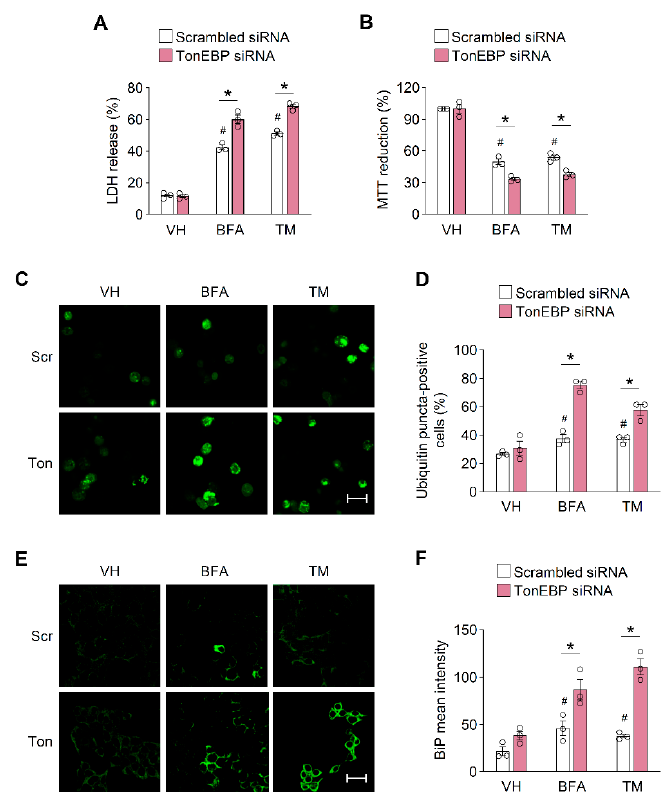
Figure 1. Tonicity-responsive enhancer-binding protein (TonEBP) prevents the accumulation of unfolded proteins. ( A , B ) MIN6-M9 cells were transfected with scrambled siRNA or TonEBP-targeted siRNA, and then treated with vehicle (VH), brefeldin A (BFA; 20 µ M), or tunicamycin (TM; 1 µ g / mL). Cell viability was assessed by the LDH release ( A ) and MTT reduction ( B ) after 24 h. ( C ) Cells were transfected with scrambled siRNA (Scr) or TonEBP-targeting siRNA (Ton) and then treated as above. Ubiquitin was visualized with an anti-ubiquitin antibody by immunostaining. ( D ) Percent of ubiquitin puncta positive cells were counted from 100 cells in each group. ( E ) Cells were transfected and treated as in ( C ). BiP was detected with an anti-BiP antibody by immunostaining. ( F ) Percent of BiP positive cells were counted from 100 cells in each group. VH, vehicle. Data (mean + SD) were from three independent experiments ( n = 3) each with more than three replicates. # p < 0.05 vs. scrambled siRNA-VH. * p < 0.05 (( A , B ); unpaired t -test, ( D , F ); one-way ANOVA). Scale bars, 50 µ m ( C , E